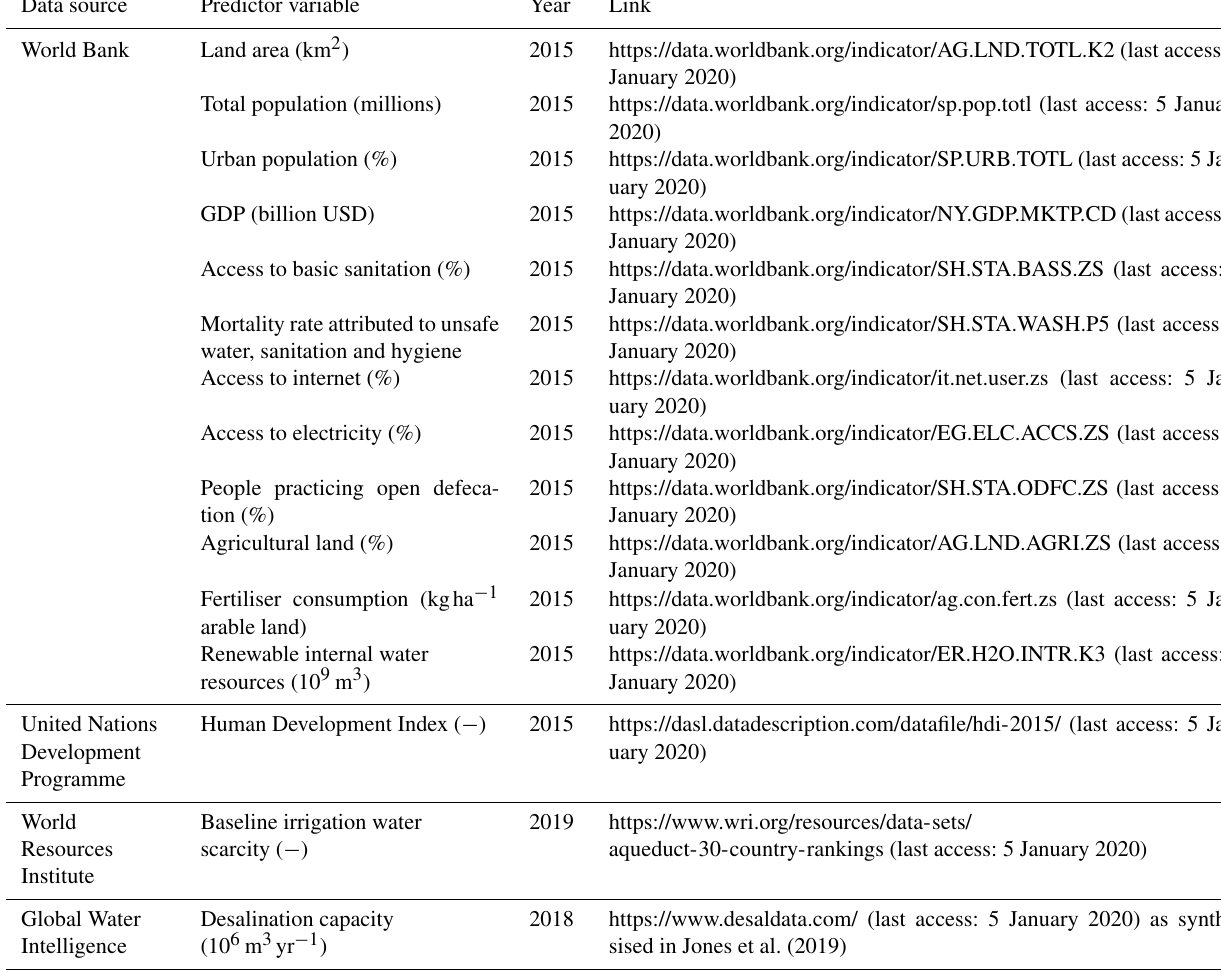
Table 2. Data sources of predictor variables for wastewater production, collection, treatment and reuse regression